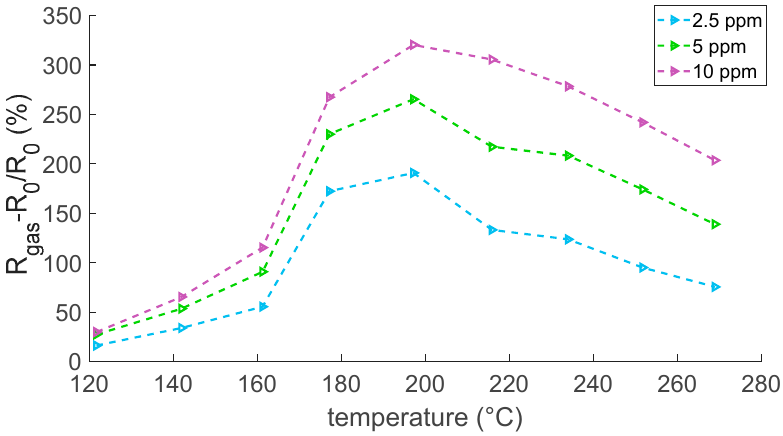
Figure 9. Responses to NO 2 as a function of temperature; N 2 is the carrier gas.